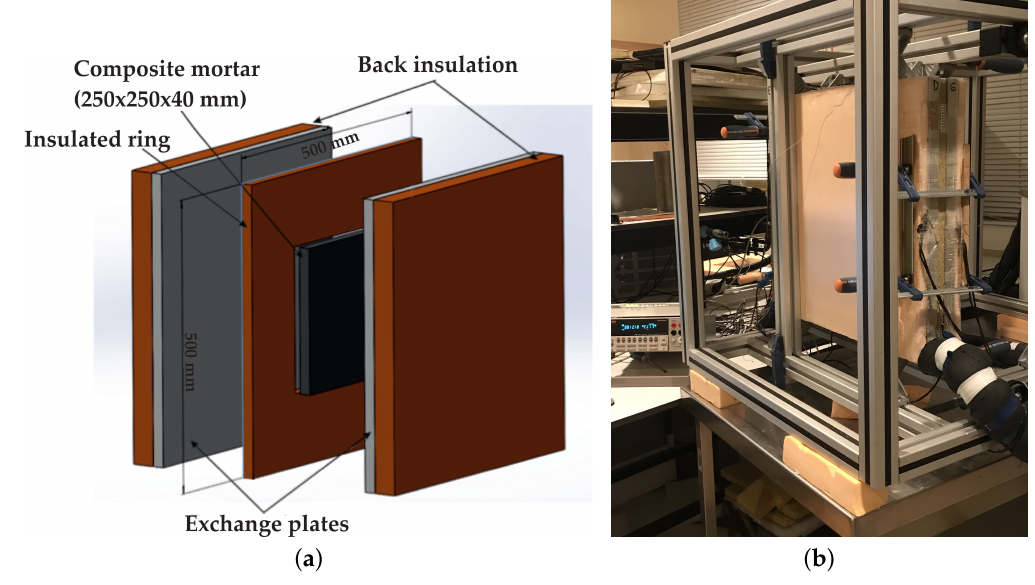
Figure 2. Schematic view of the experimental set-up. ( a ) Exploded view; ( b ) Real